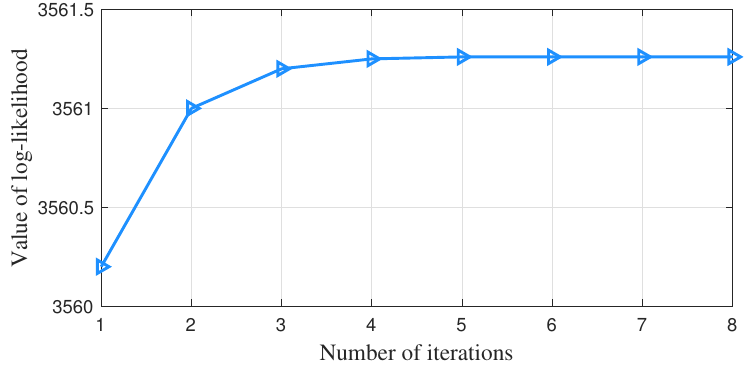
Figure 6. The change in the log-likelihood function value under the EM algorithm.